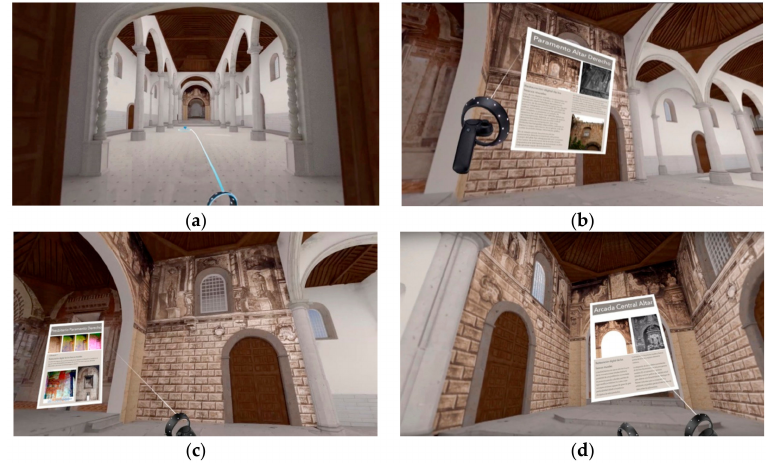
Figure 16. Virtual interactive actions developed for the program: ( a ) teleportation, which allows the user to move around the scene, and ( b – d ), selection by pressing the virtual button, which allows the user to view specific information on the